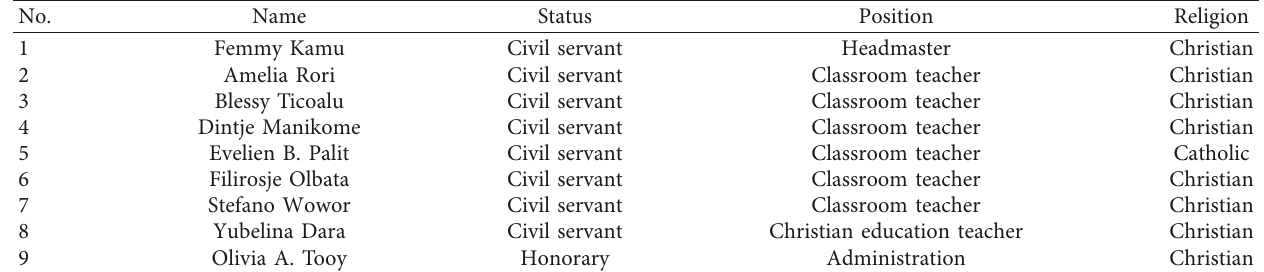
Table 5: Data for educators and education at the Kawangkoan North Minahasa Presidential-Instruction Elementary School.